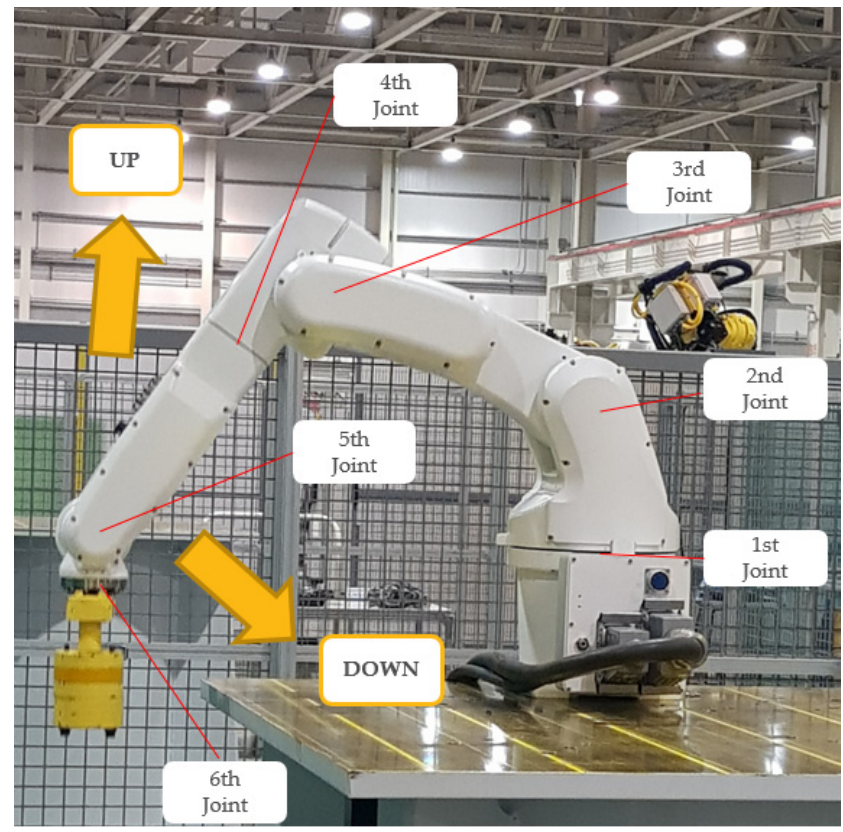
Figure 7. The manipulator is moving up and down for the experiment. The cable conditions were divided into eight classes according to the left cross-sectional area S f of the target wire, as shown in Table 1. For the experiments, a healthy target cable is prepared and damaged gradually to collect normal and fault datasets. 5000 selected windows per fault-severity class from the measured three-phase currents were utilized as training, validation, and testing datasets. The collected datasets for each severity are shown in Table 3. Each dataset is produced by windowing the measured currents and the length of the window was 9000. The 0 cut dataset, i.e., healthy cable, were used for training (3000 samples), validation (1000 samples), and testing (1000 samples) under the normal condition. The 4 cut–28 cut datasets were used as novelty testing dataset (1000 samples). For example, the 4 cut is a slight fault case with a large α compared to that of the other data; whereas, the 28 cut is a severe fault case with a small α , where only 2 strands are left out of the 30 strands owing to the harsh